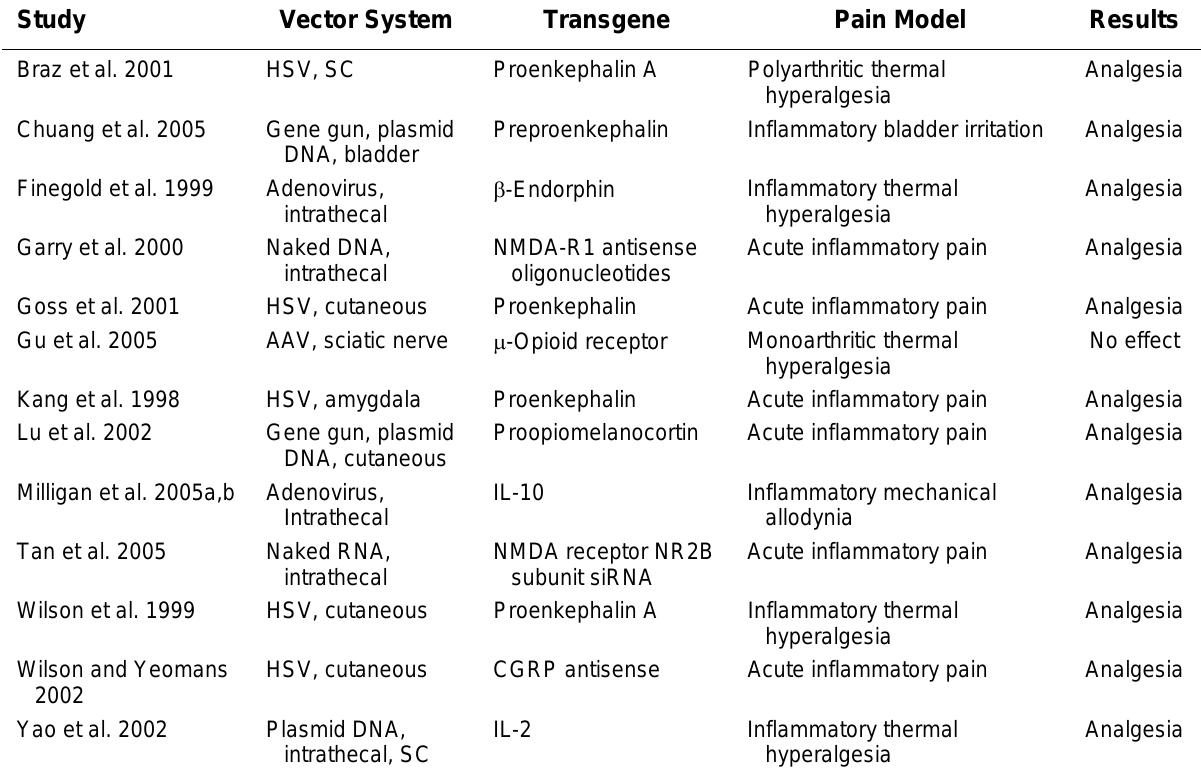
Effect of Gene Therapy on Inflammatory Pain Sensitivity in